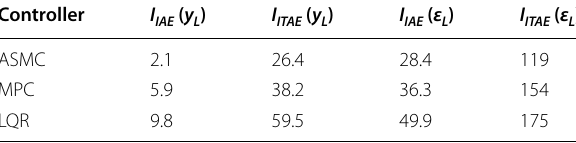
Table 3 Error performance indexes in experimental test